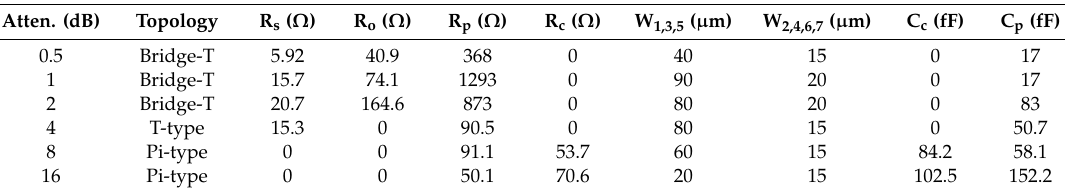
Table 2. Component values of each proposed attenuator unit.